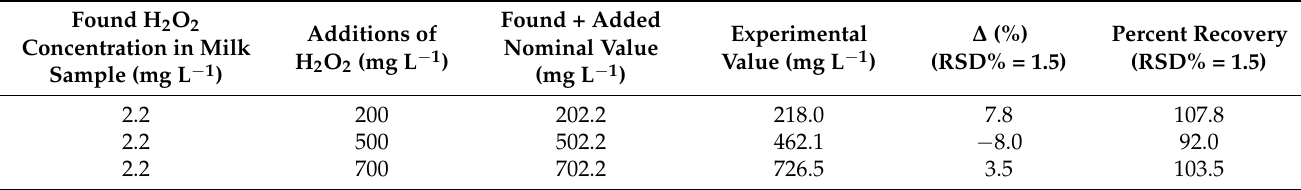
Table 4. Experimental percent recovery for hydrogen peroxide addition in commercial cow’s milk sample by Clark-type LDH-catalase enzyme